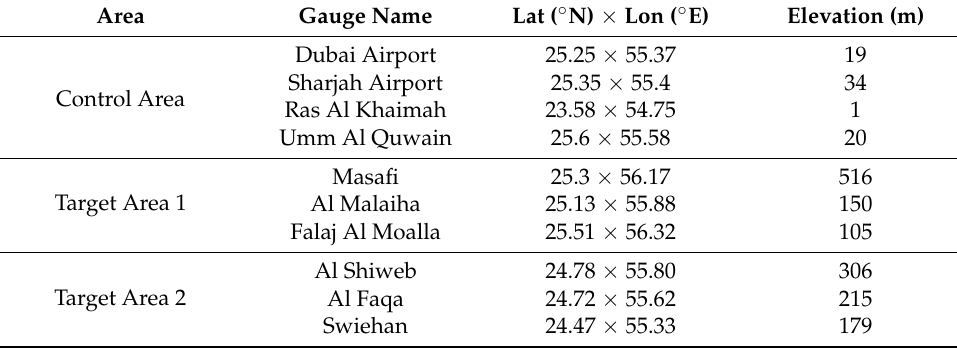
Table 1. Location and elevation of control and target area rain